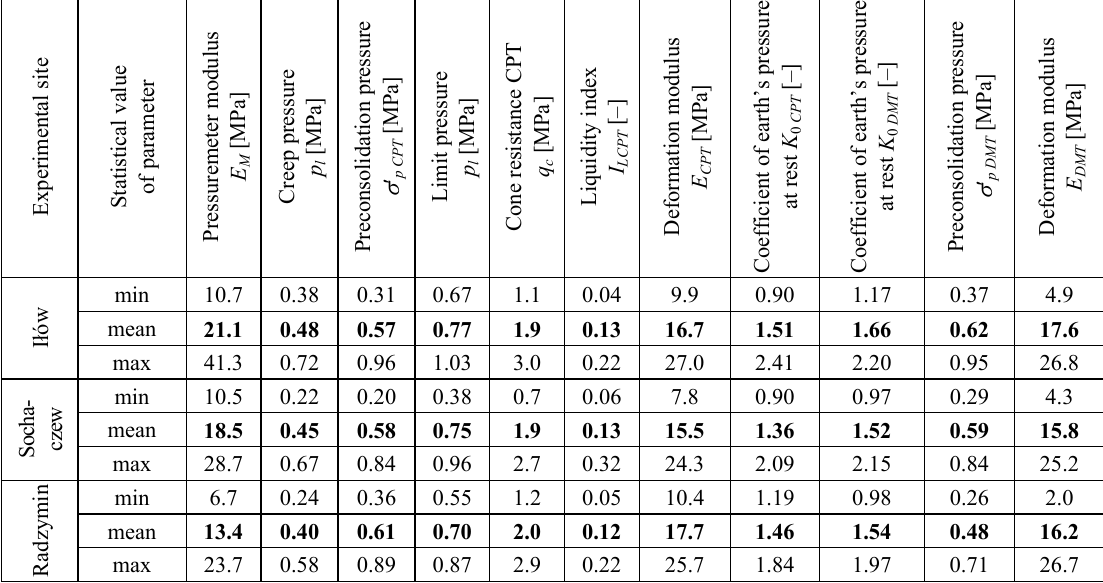
Table 2. Comparison of the results from three experimental sites from the Warsaw Ice-Dammed Lake